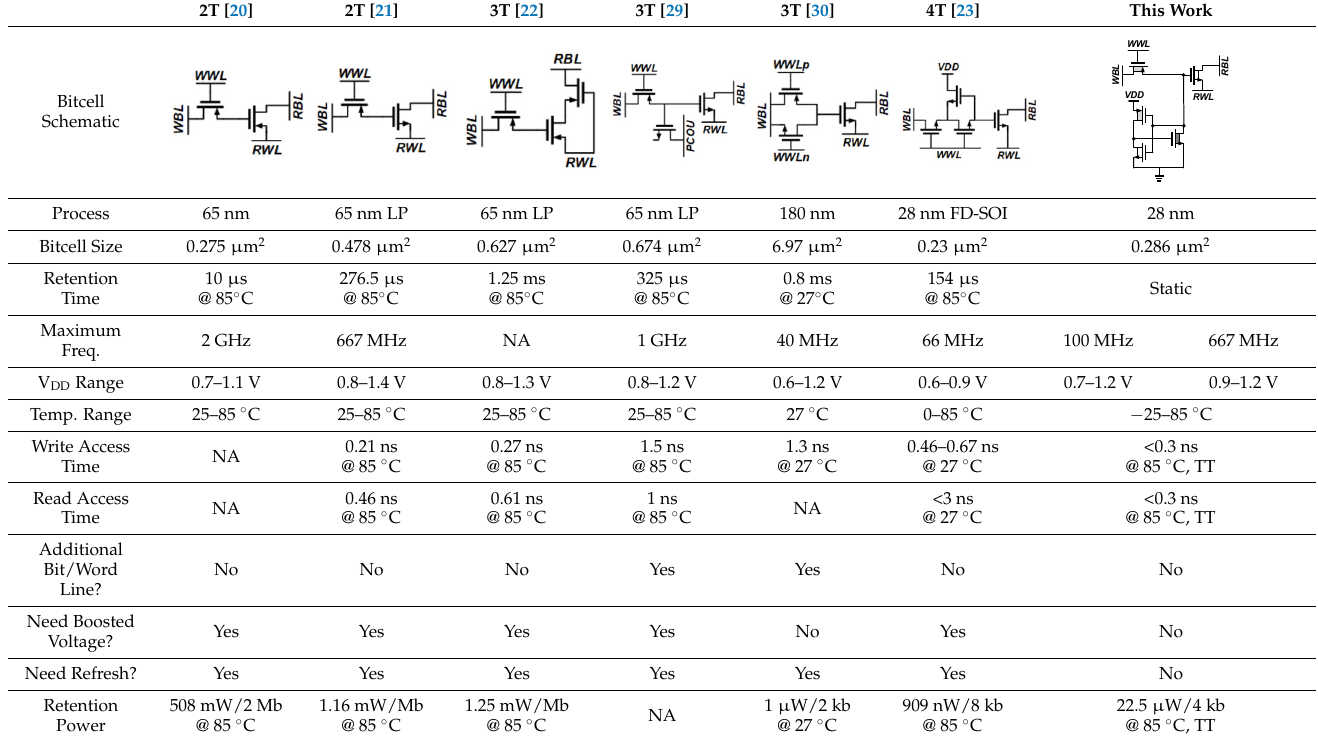
Table 2. Performance summary and comparison with previous works.